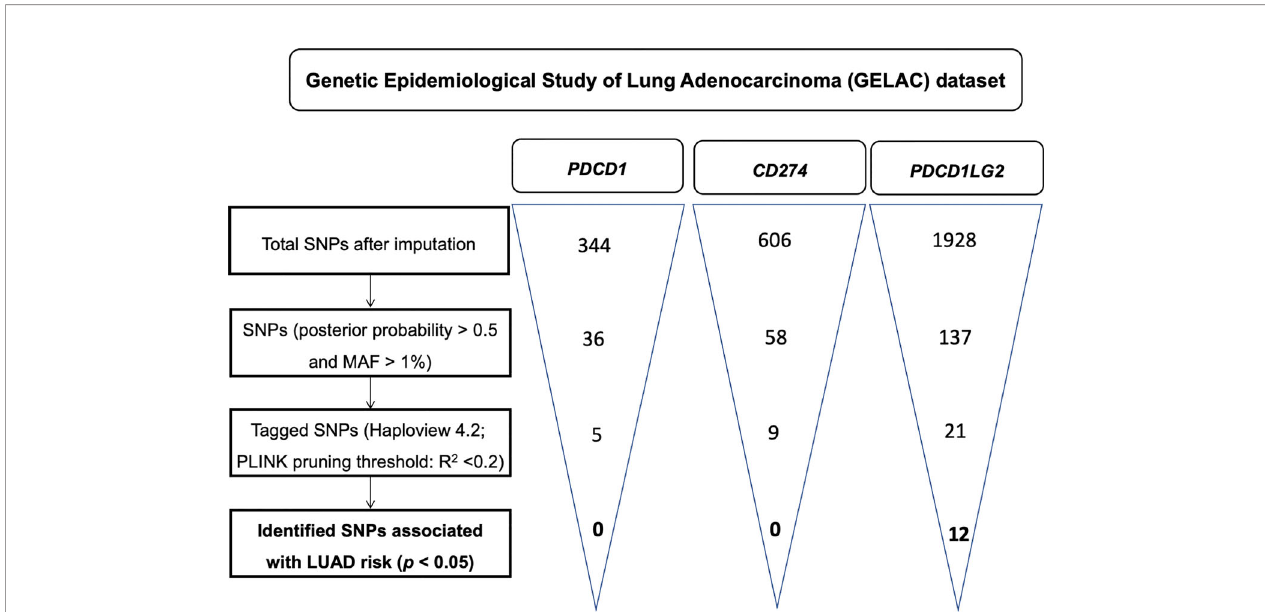
FIGURE 1 | A fl owchart for the identi fi cation of single nucleotide polymorphisms (SNPs) associated with the risk of lung adenocarcinoma in PDCD1 , CD274 , and PDCD1LG2